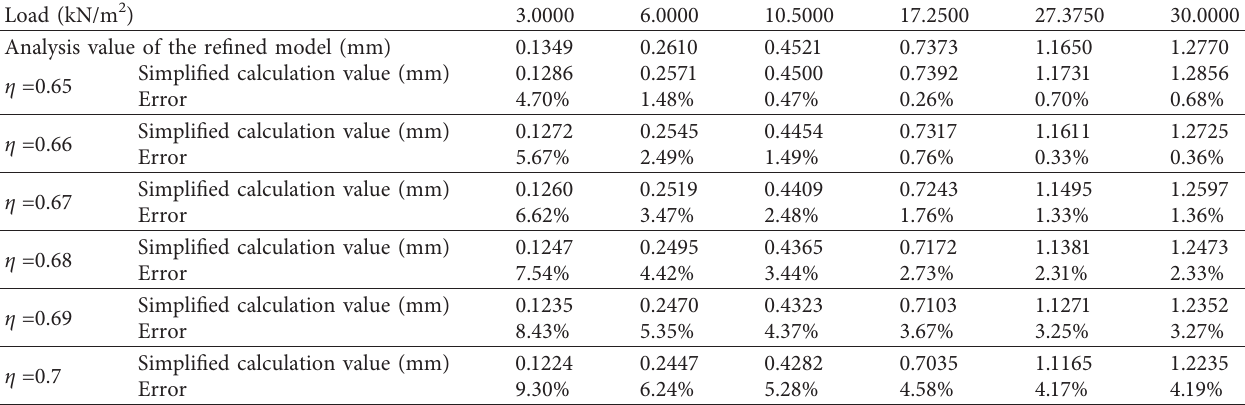
Table 9: Comparison of the deflections of different stiffness reduction factors for the three-span continuous